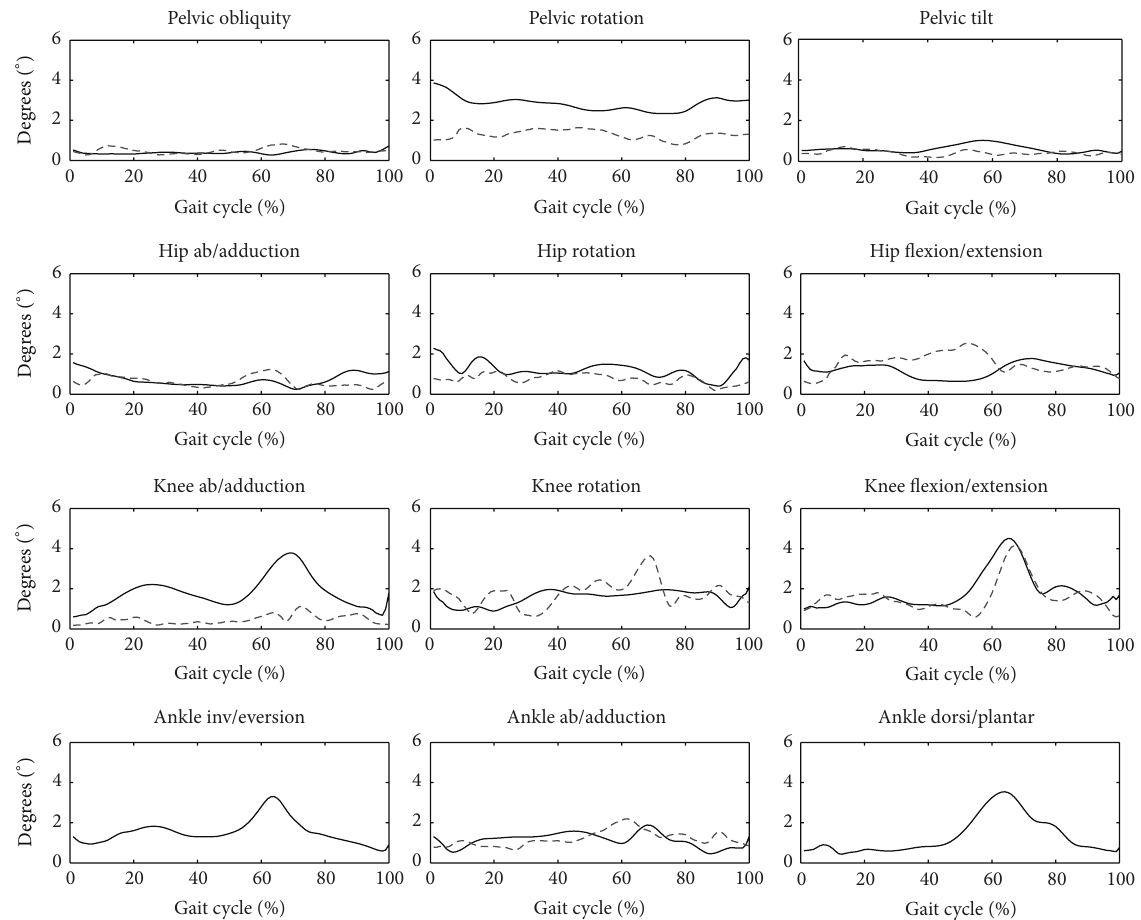
Figure6:Patternsofintertrialvariabilityacrossallsamplesofthegaitcycle,averageforfoursubject.HH—greydashedline,ISB6DOF—black solid